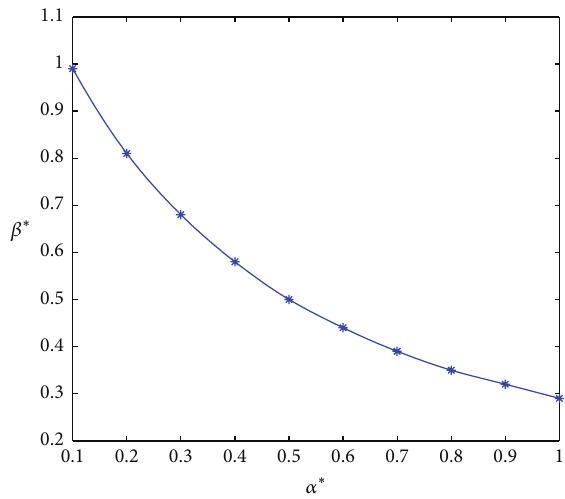
Figure 4: The curve of 𝛽 ∗ along with 𝛼 ∗ .